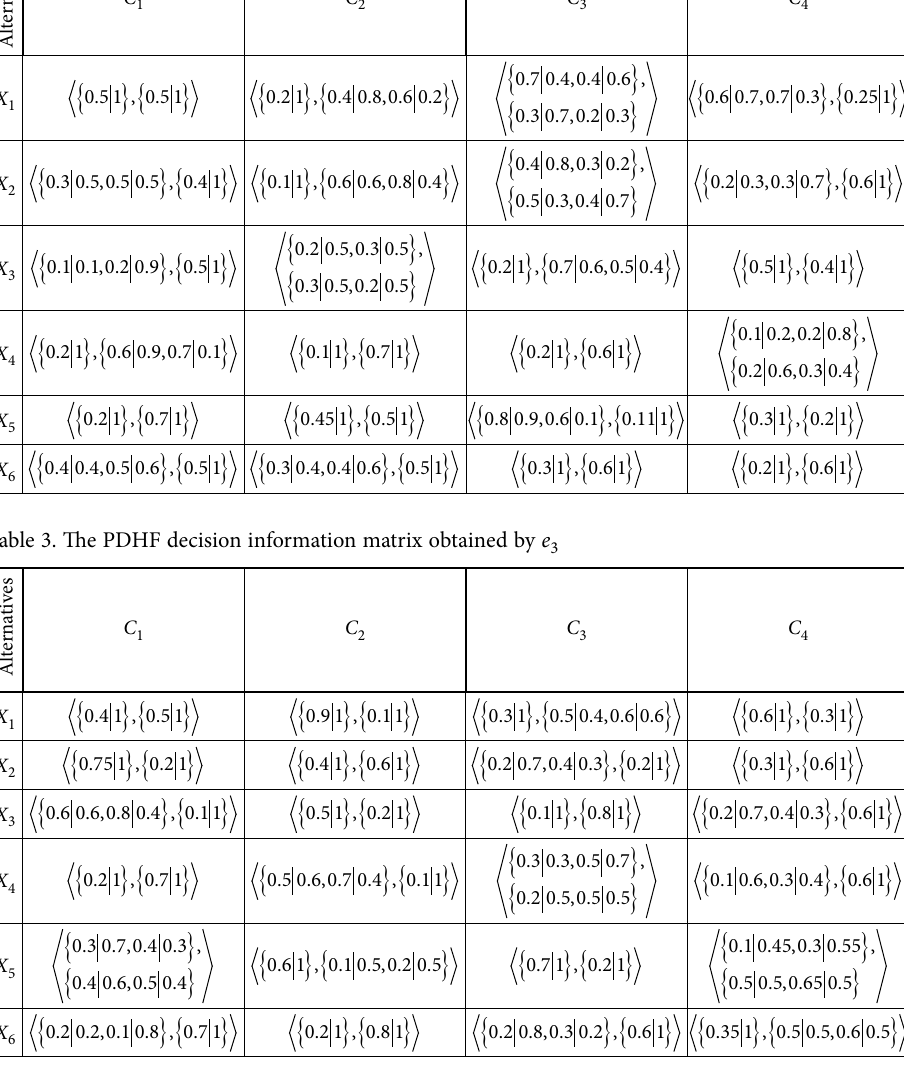
Table 2. The PDHF decision information matrix obtained by e 2 n r t e A l